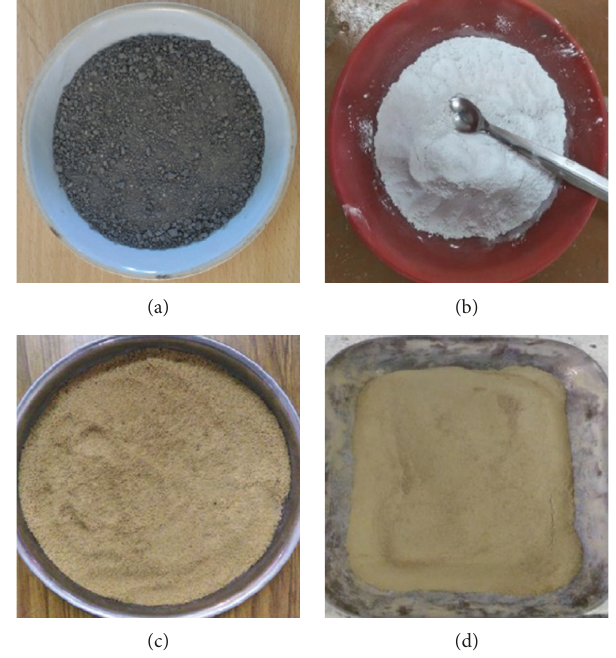
Figure 1: (a) Soil, (b) lime, (c) jaggery, and (d) gallnut